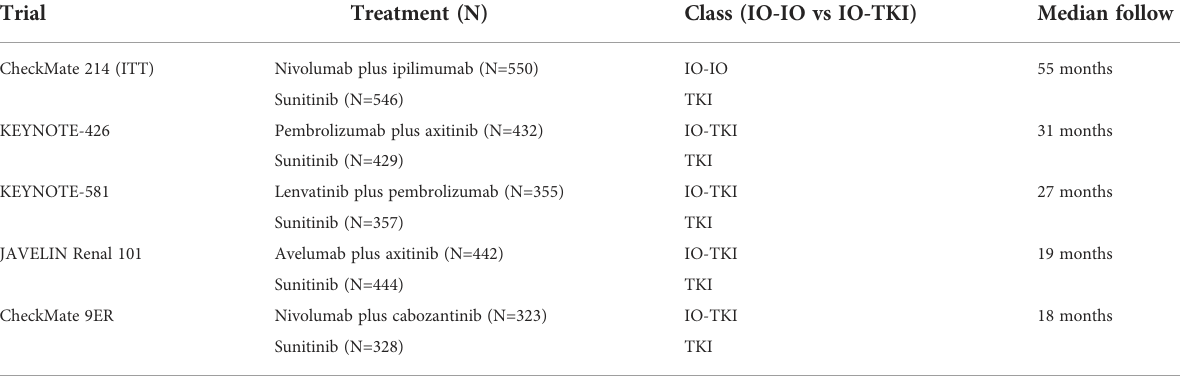
TABLE 1 Characteristics of included trials.